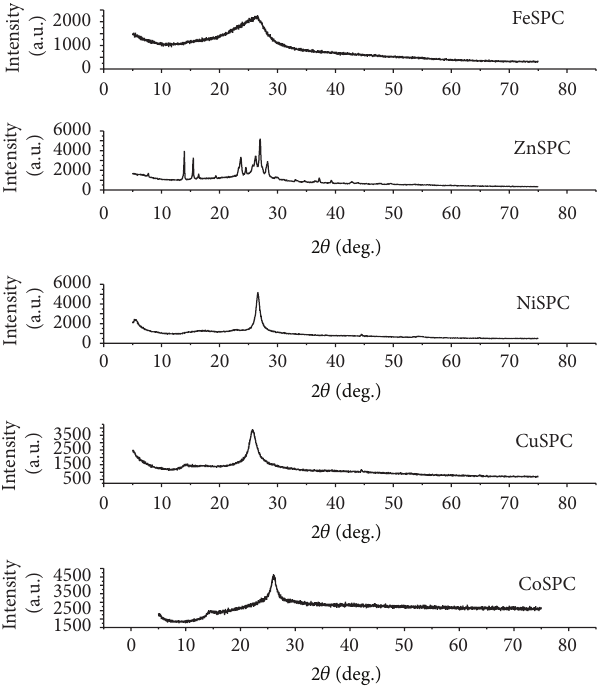
Figure 2: XRD patterns of the sulfonated phthalocyanine